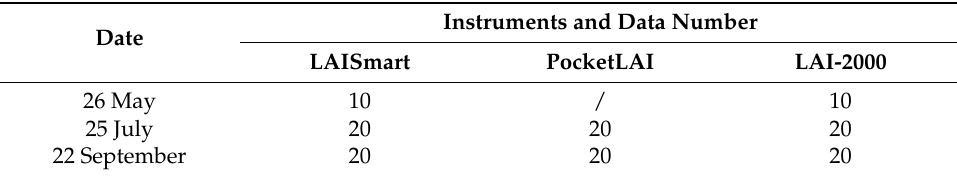
Table 2. The instruments and the data number on every experiment date. Date